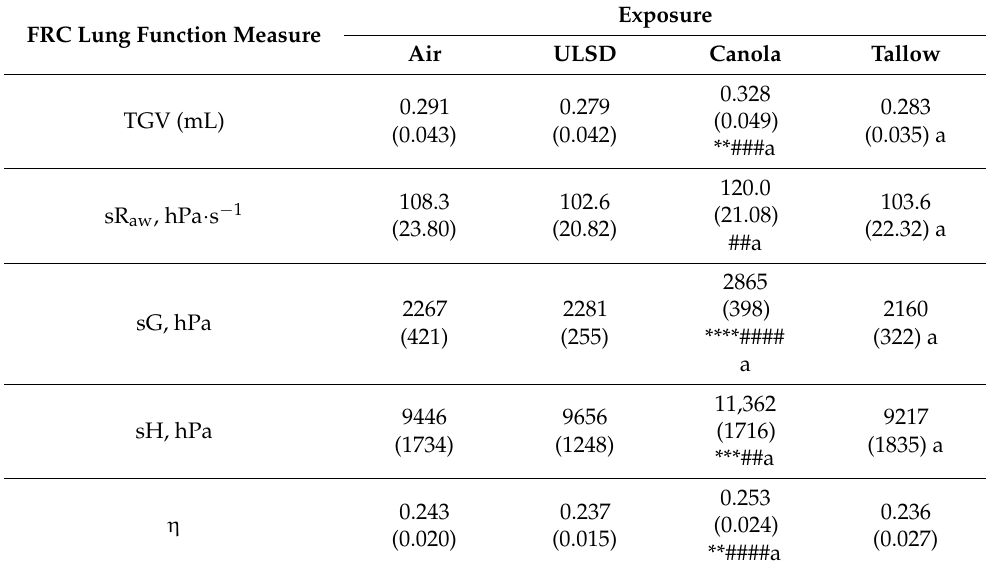
Table 2. Mean (standard deviation) thoracic gas volume (TGV) and specific lung function at FRC for mice exposed to Air, ULSD, Canola, or Tallow biodiesel exhaust for 8 days as measured by plethysmography and the forced oscillation technique ( n = 22–24 per group). As significant differences in TGV were measured between groups, FRC lung function measurements have been normalized to TGV. Data were analyzed using general linear modeling